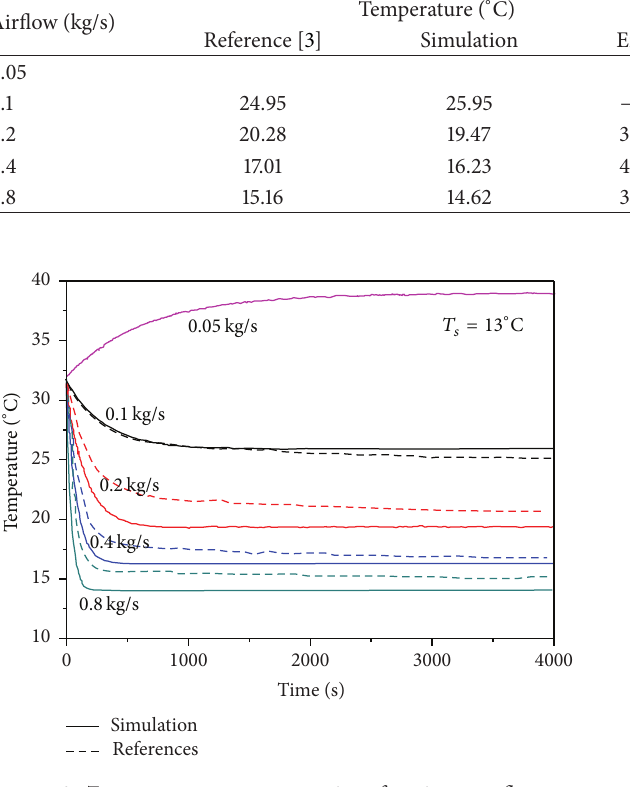
Figure 8: Zone temperature versus time for air mass flow rate compared with [6]. Figure 9: Zone humidity ratio versus time for air mass flow rate compared with